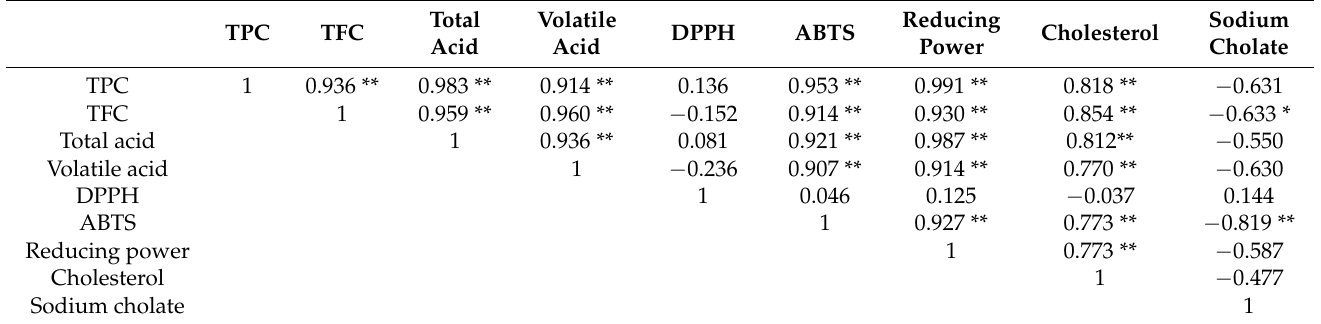
Table 2. Linear correlation coefficients of functional properties of green jujube